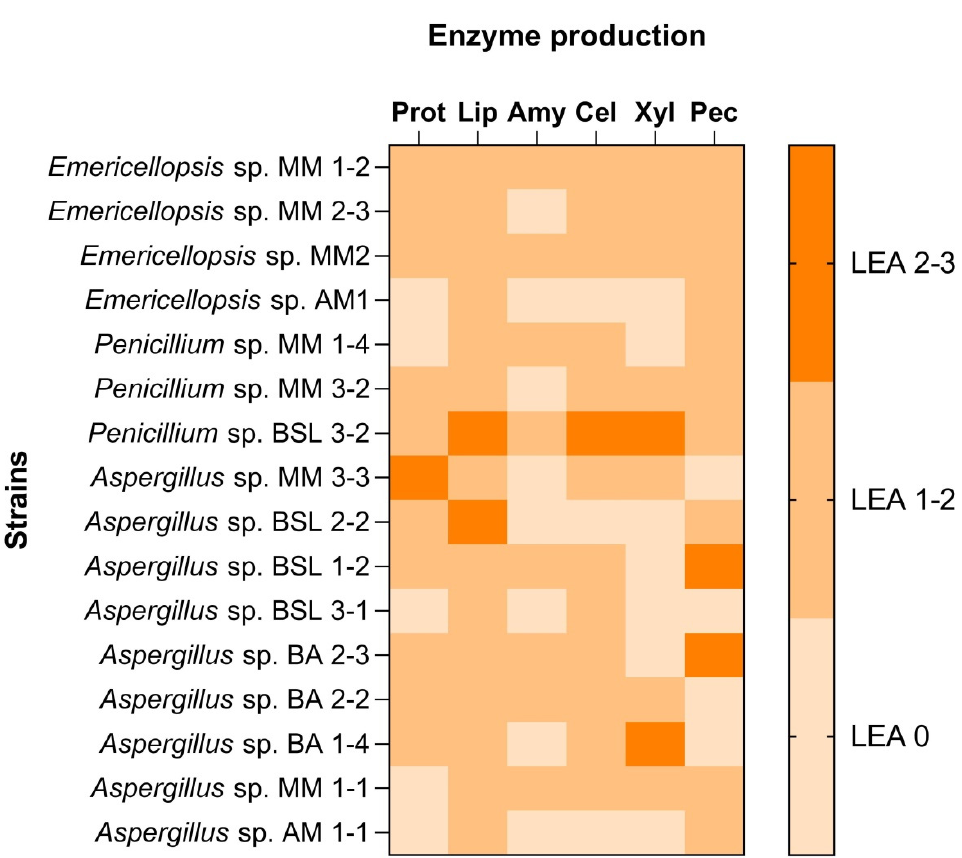
Figure 3. Production of hydrolytic enzymes by different strains of Aspergillus , Penicillium and Emericellopsis (LEA: Level of Enzyme Activity).